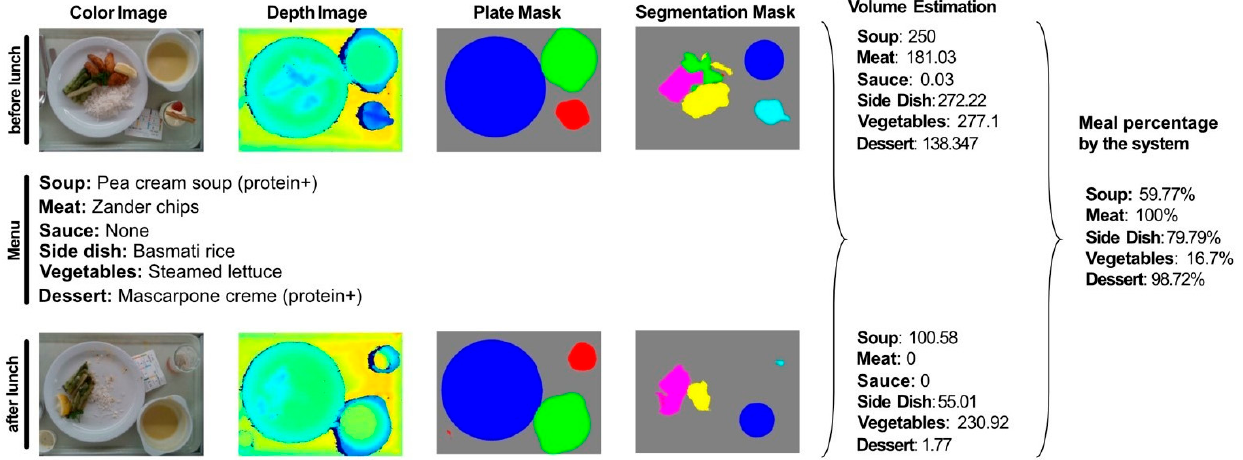
Figure 6. The system receives as input the daily menu, the RGB-D images, and the plate and meal segmentation masks and estimates the volume of each dish before and after consumption.